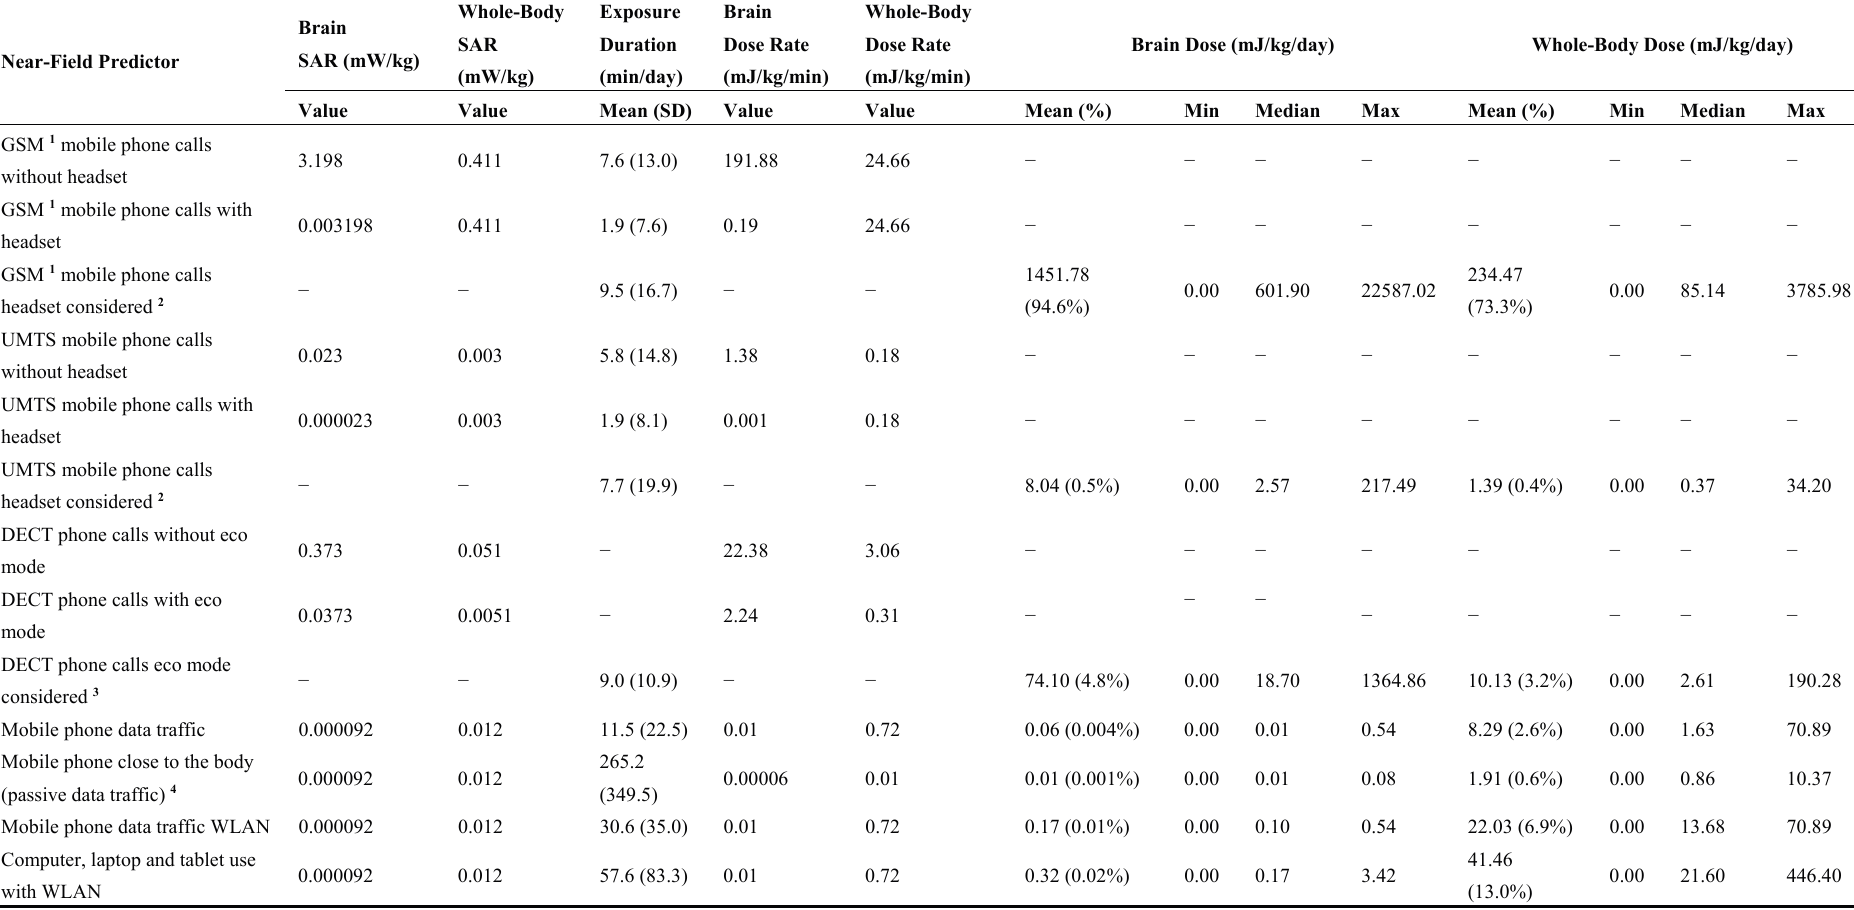
Table 3. SAR, mean exposure duration (with standard deviation), dose rate (dose per 1 min), and mean (with corresponding percentage of the total near-field dose), minimum, median and maximum of the daily cumulative dose for the brain and whole-body exposure for the near-field